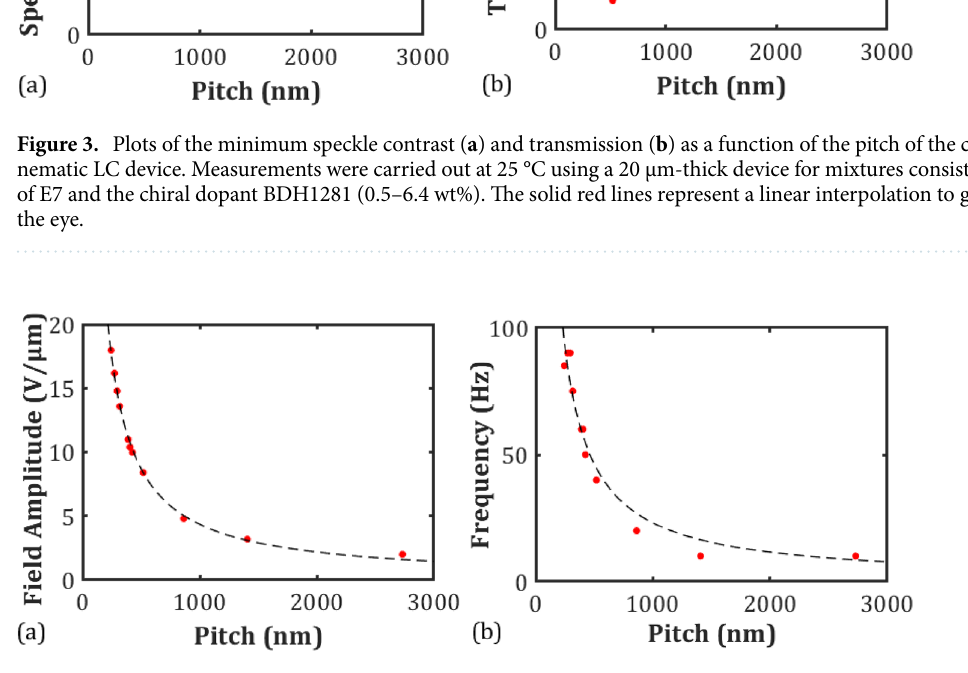
Figure 4. Plot of the amplitude ( a ) and square-wave frequency ( b ) of the applied electric field at the minimum speckle contrast (maximum speckle reduction) as a function of the pitch. Each cell was 20 μm-thick and the cell temperature throughout the measurements was held at T = 25 °C. Data points represent the measured values and the dashed black lines are fits of the form ax −1